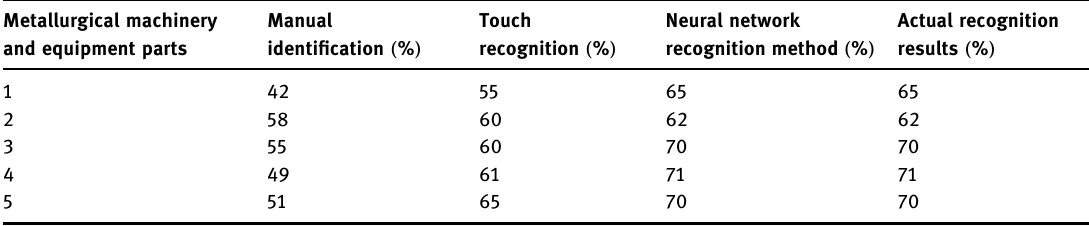
Table 2: Comparative analysis of installation error degree of three methods Metallurgical machinery and equipment